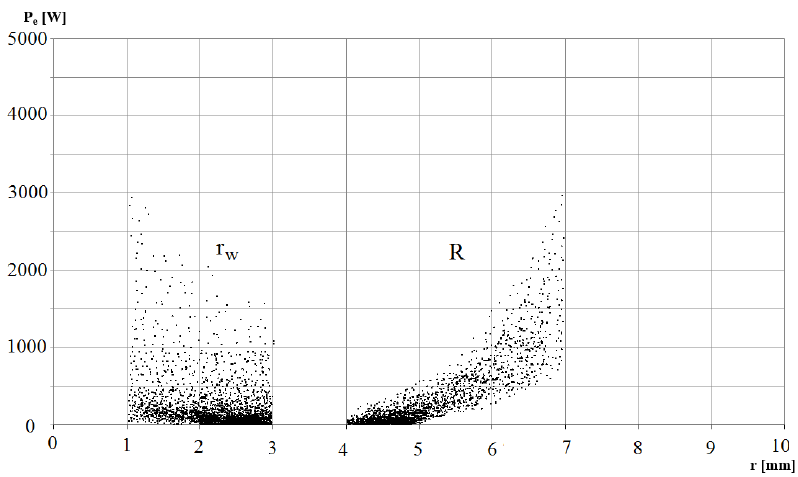
Figure 17. Dependence of the electric power P e on the radius r w and on the radius R.